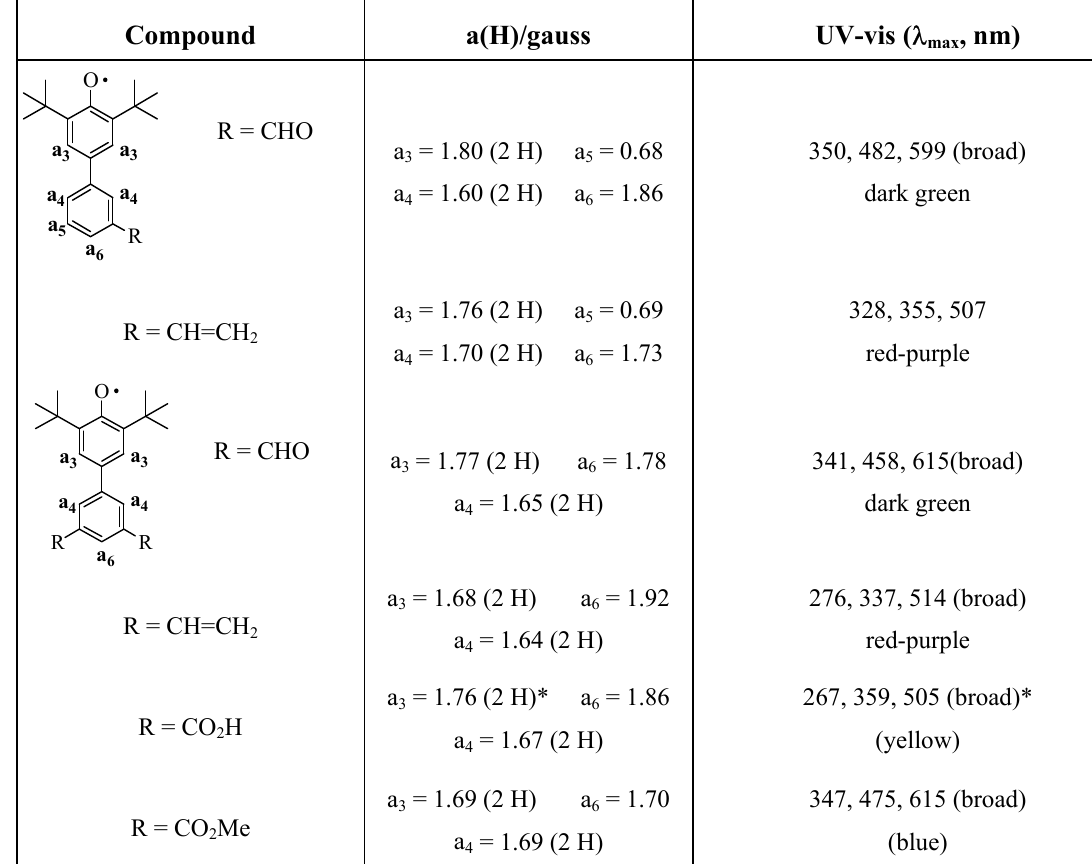
Table 1 : ESR hyperfine and UV-vis data for model phenoxyl radicals derived from phenols in Figure 2. All spectra obtained in benzene or toluene solutions at room